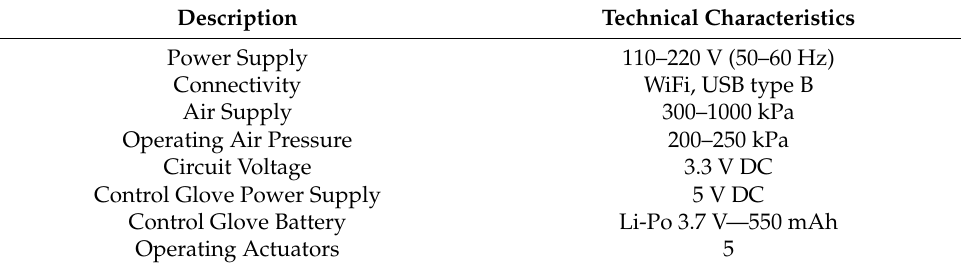
Figure 8. ( a ) Final configuration of overall SEG device along with its main components; ( b ) Illustrative flowchart of the SEG device function. Table 1. Technical characteristics of the developed SEG